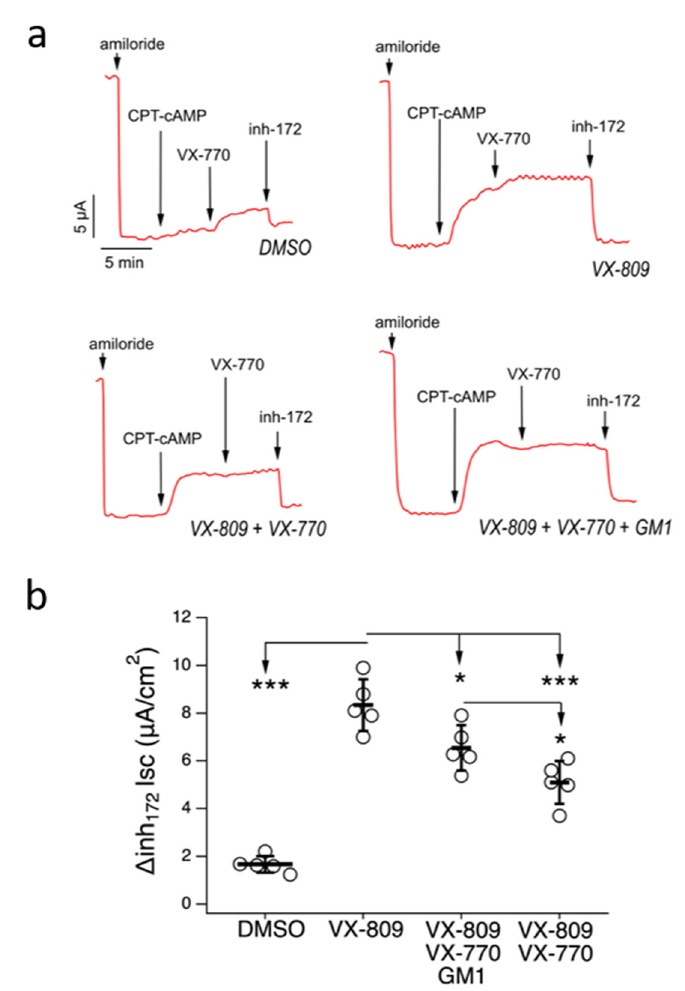
Figure 6. GM1 improves F508del rescue by combo VX-809/VX-770 treatment in primary bronchial epithelia. Representative traces ( a ) and dot plot ( b ) summarizing data from the Ussing chamber recordings of human primary bronchial epithelia from a homozygous F508del patient, treated with VX-809 (5 µM), VX-809/VX-770 (5 µM/5 µM), VX-809/VX-770/GM1 (5 µM/5 µM/50 µM) or DMSO. Symbols indicate statistical significance: *** p < 0.001, * p < 0.05.